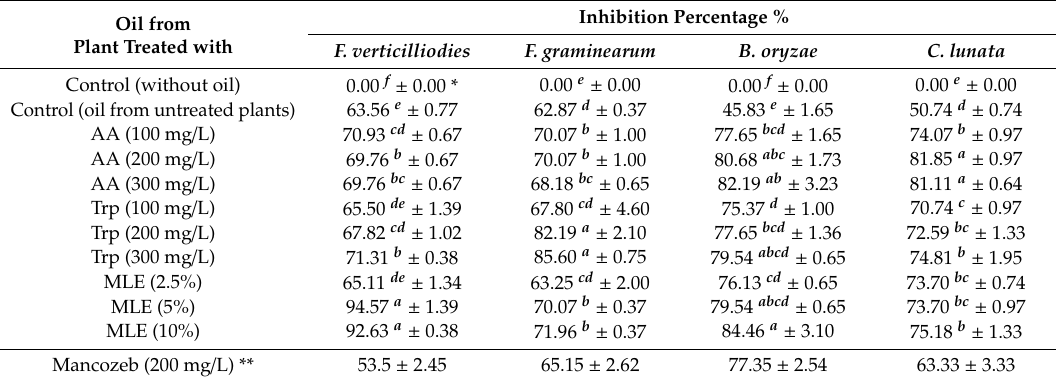
Table 6. Antifungal activity of the essential oils against the growth of F. verticilliodies , F. graminearum , B. oryzae and C. lunata